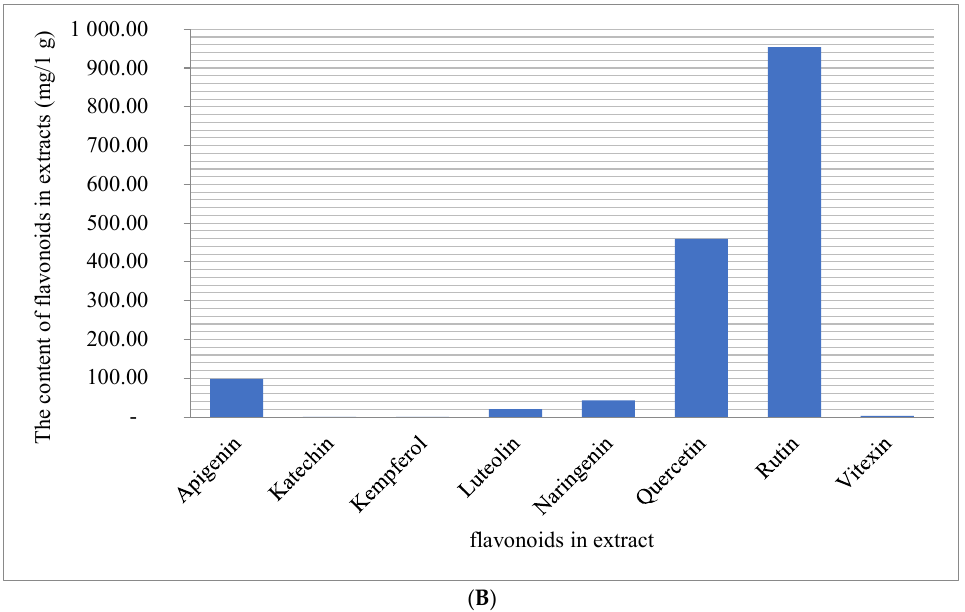
Figure 1. ( A ) The content of flavonoids in the plants tested. *—value for rutin and quercetin ×10. ( B ) the content of flavonoids in Elderberry fruit ( Sambucus nigra L.) tested.